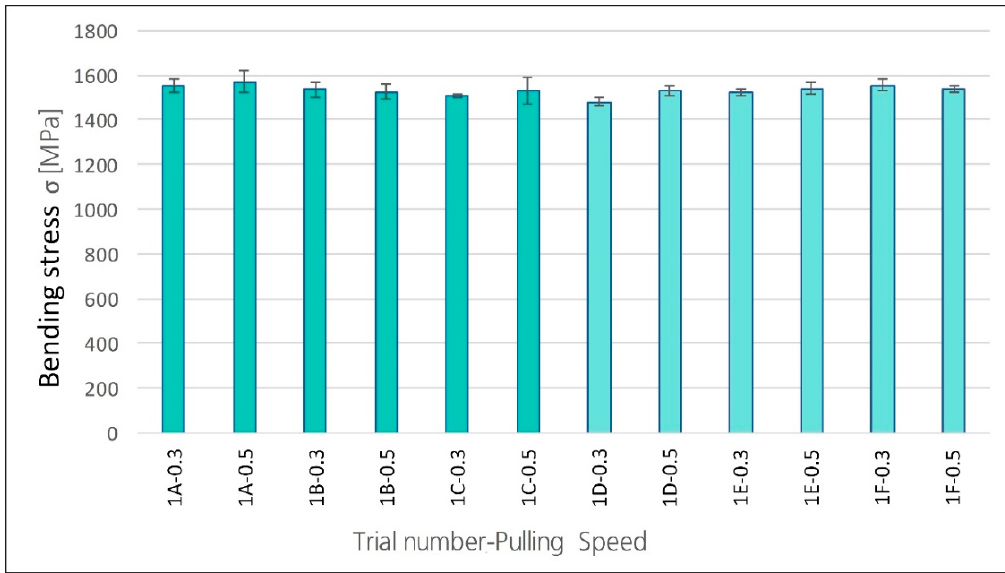
Figure 5. Bending stress for different pulling speeds and resin mixing times .